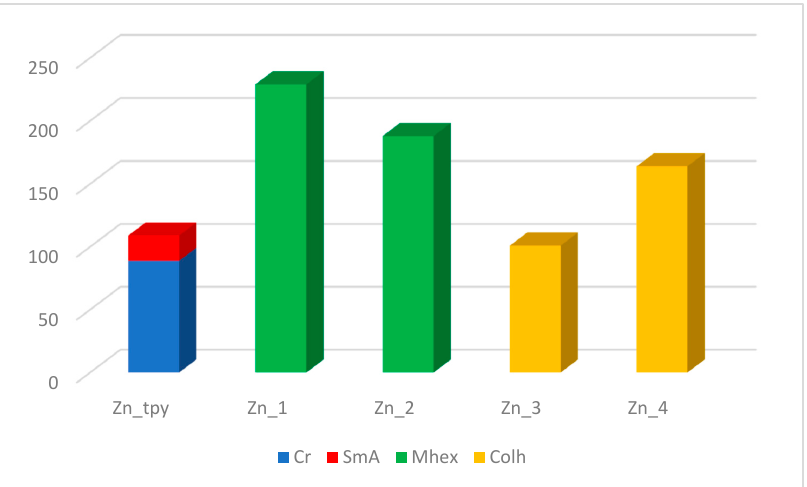
Figure 4. Mesomorphic behaviour of Zn(II) coordination complexes: Cr—crystalline phase; SmA—smectic A mesophase; M hex —three-dimensional mesophase with a two-dimensional hexagonal lattice symmetry, Col h : two-dimensional columnar hexagonal mesophase. DSC data on the second cooling cycle.